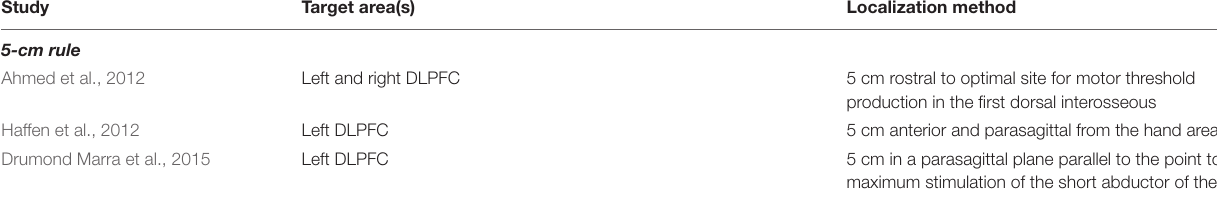
TABLE 1 | Summary of the target areas and localization methods adopted in previous rTMS interventions in AD patients. Study